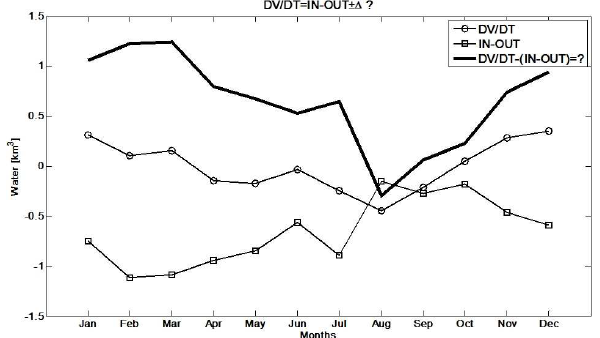
Fig. 8. Total water balance. Difference between total inflow and total outflow ( − ⁄ − ) , lake volume variation ( −◦− ) and DV/DT − ( IN − OUT ) = ∆? ( — ) . error.